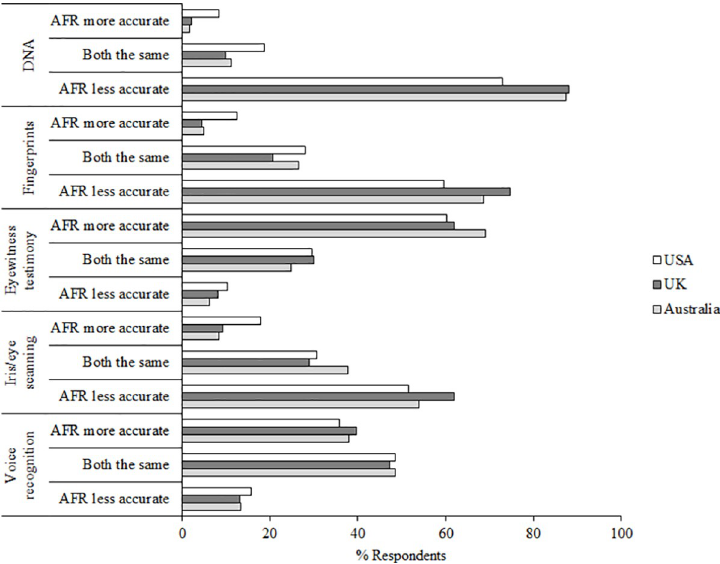
Fig 11. Question 18 data. Responses to question 18 “How accurate do you think this type of facial recognition technology is compared to these different forms of identification?”.